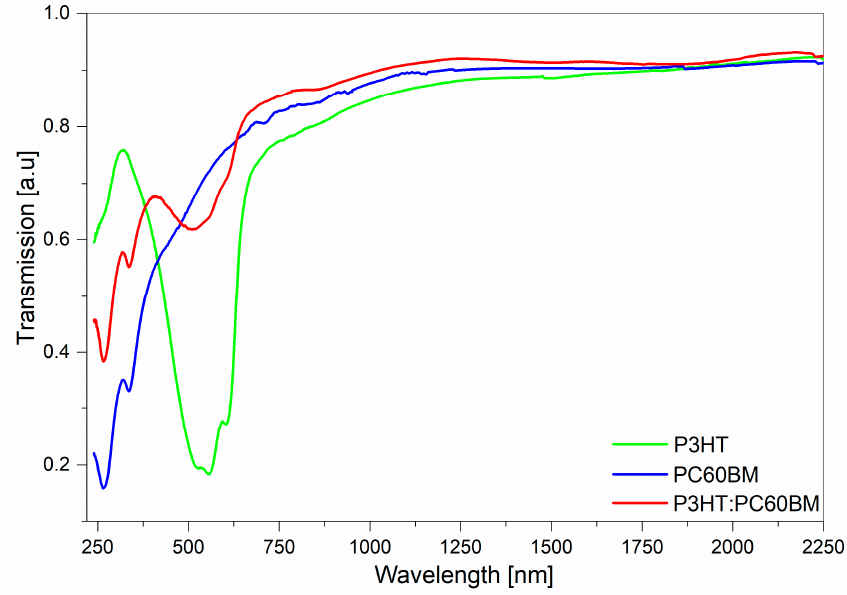
Figure 3. Spectra of P3HT, PC60BM, and P3HT:PC60BM taken in ellipsometer transmission mode.